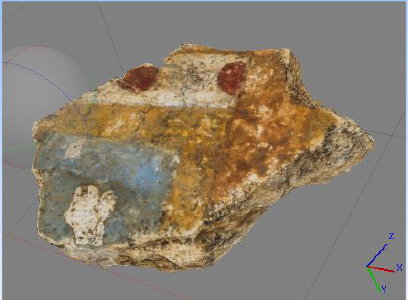
Figure 6: The 3D textured model of the fragment